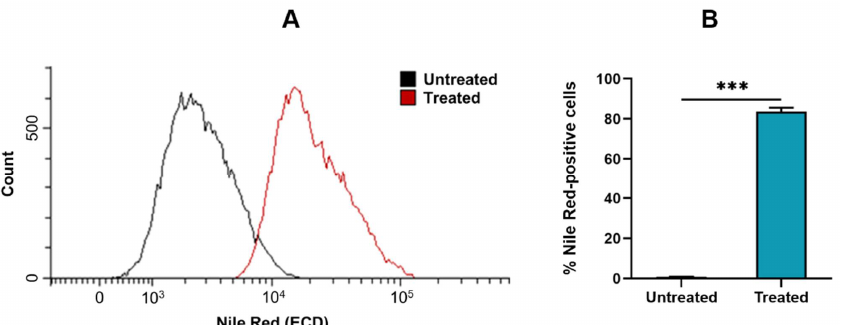
Figure 6. Cellular uptake of the GM-SLN vector by Hep G2 cells. ( A ) Flow cytometry histogram of the cellular uptake study. ( B ) Percentage of Nile Red-positive cells. The percentage of Nile Red-positive cells corresponds to cells containing the Nile Red-labeled GM-SLN vector over total cells. Results are shown as the mean ± standard deviation ( n = 3). Statistical significance: *** p < 0.001. As shown in Figure 6A, the rightward shift of the histogram obtained from the cells treated with the vector demonstrated the efficient internalization of the GM-SLN vector into Hep G2 cells, which was taken up by 83.51 ± 2.02% of cells (Figure 6B).